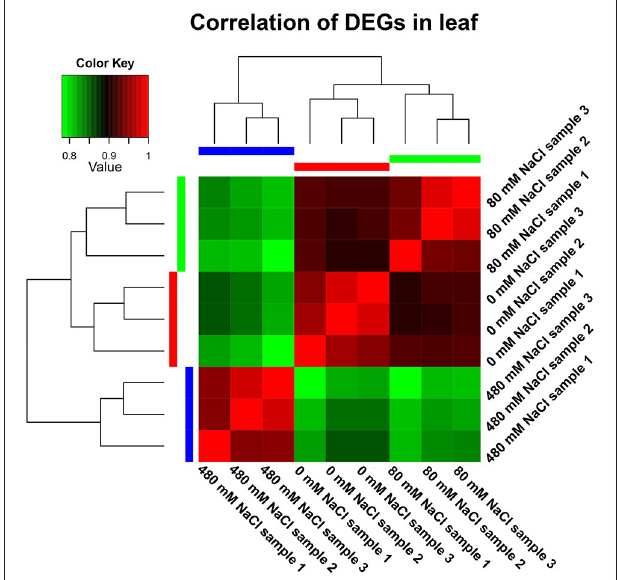
FIGURE 1 | Correlation analyses of gene expression from nine leaf samples. The 30-d-old seedlings were subjected to 0, 80, and 480mM NaCl for 2